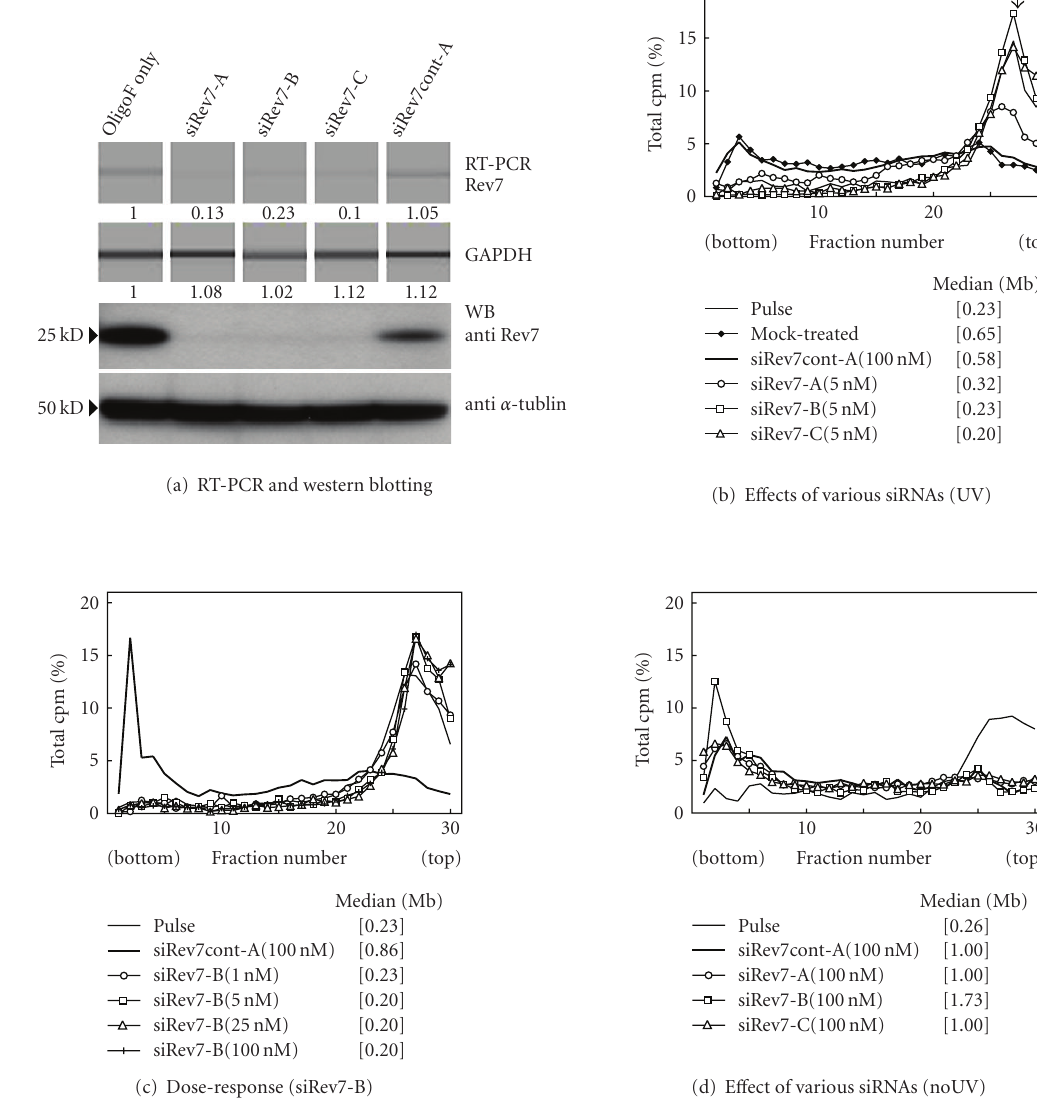
Figure 2: E ffi cient knockdown by Rev7 siRNAs and their e ff ects on UV-induced TLS in HeLa cells (ASDG profiles of replication products). (a) E ffi ciency of knockdown on Rev7 expression (RT-PCR analysis and western blot analysis); (b) E ff ects of various Rev7 siRNAs; (c) Dose- response of siRev7-B; (d) E ff ect of various Rev7 siRNAs (no UV control). Twenty-four hours after Rev7 siRNA transfection, total RNA was isolated and Rev7 RNA was quantified by RT-PCR. Results were shown in MultiNA gel images and the expression level was presented under the panel (a). Forty hours after Rev7 siRNA transfection, whole cell extracts were prepared and Rev7 protein was quantified by western blot analysis (a). Forty hours after Rev7 siRNA transfection, cells were UV-irradiated (10J/m 2 ), incubated in normal medium for 30 minutes, pulse-labelled with 10 μ Ci/mL of [ 14 C]thymidine for 1 hour, washed twice with PBS, and incubated for 5 hours at 37 ◦ C in normal medium (b, c). Forty hours after Rev7 siRNA transfection, cells were not UV-irradiated, pulse-labelled with 10 μ Ci/mL of [ 14 C]thymidine for 30 minutes, washed twice with PBS, and incubated at 37 ◦ C in normal medium for 1 hour (d). Some of these profiles overlap (c, d). Sedimentation is from right to left. The arrow indicates the position of T4 phage DNA (166kb, i.e., approximately 5 . 5 × 10 7 Da/single strand). Average fragment length (in Mb) of each profile is shown in square